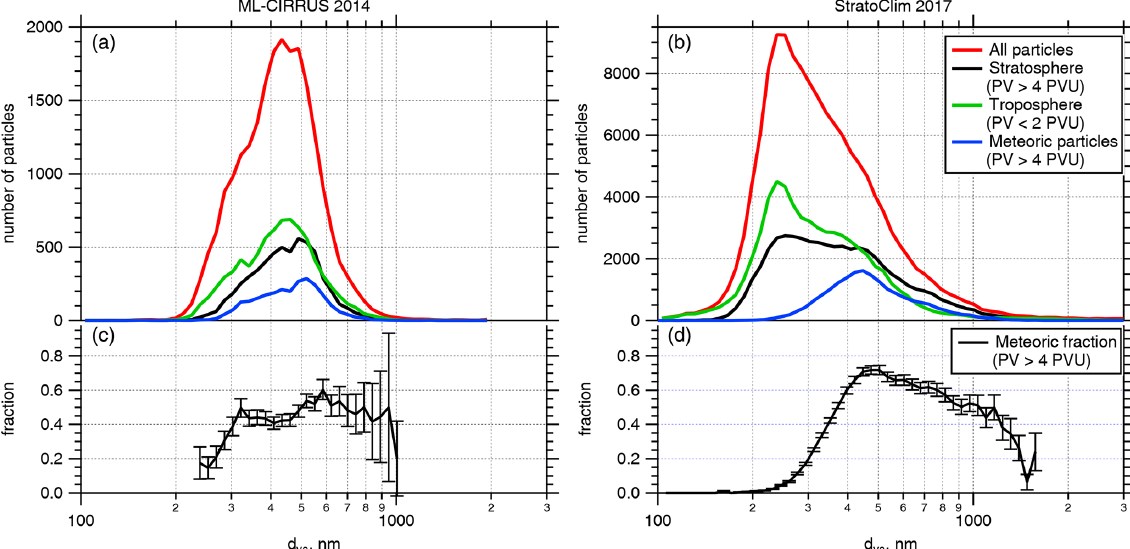
Figure 6. Number of analysed single particles as a function of particle size (vacuum aerodynamic diameter, d va ) measured during ML- CIRRUS 2014 (a, c) and StratoClim 2017 (b, d) . Panels (a) and (b) show the absolute number of counted particles per size bin; (c) and (d) show the fraction of particles with a meteoric composition signature in the stratosphere (PV > 4PVU). Error bars were calculated from Poisson counting statistics (number of particles per size bin) and were propagated for the particle